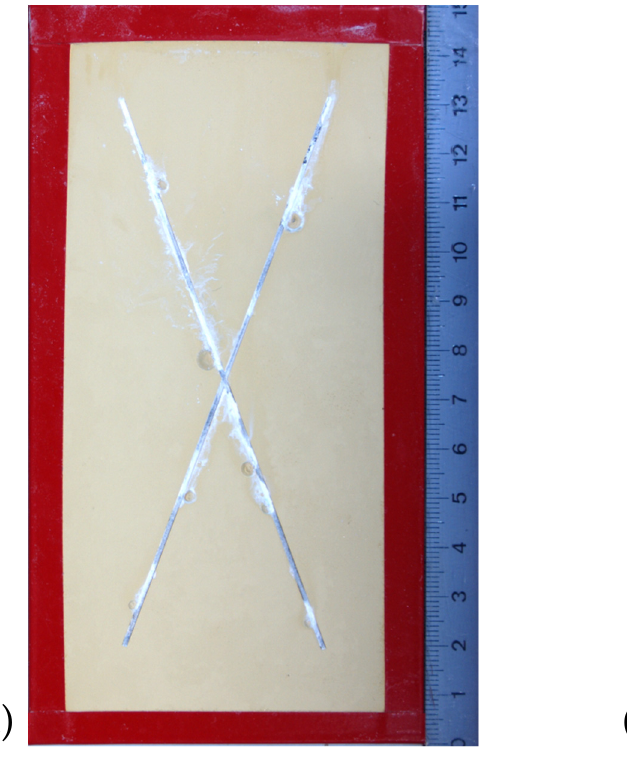
Table 4. Summary of filiform corrosion test